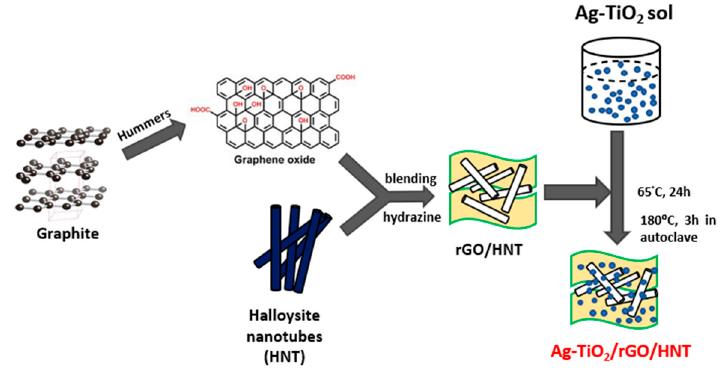
Figure 13. Schematic diagram of Ag-TiO 2 /rGO/HNT synthesis.